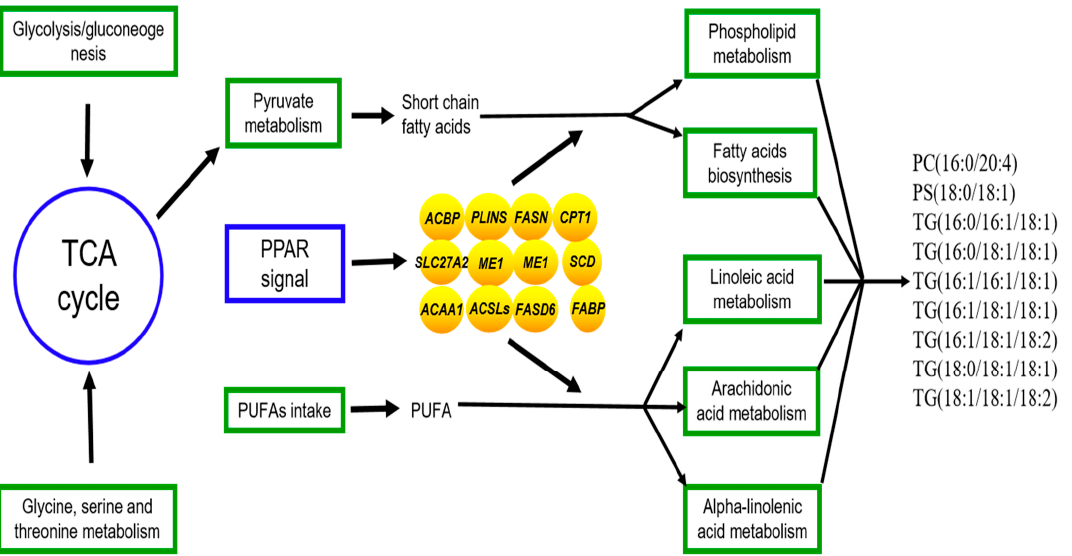
Figure 5. The regulation of genes to lipid metabolism in yak’s LD by the joint analysis of the lipidomics and transcriptome. Oval, box, text without borders represent the crucial DEGs, metabolic pathway or signaling pathway and crucial SDLs. → : regulate or result in.